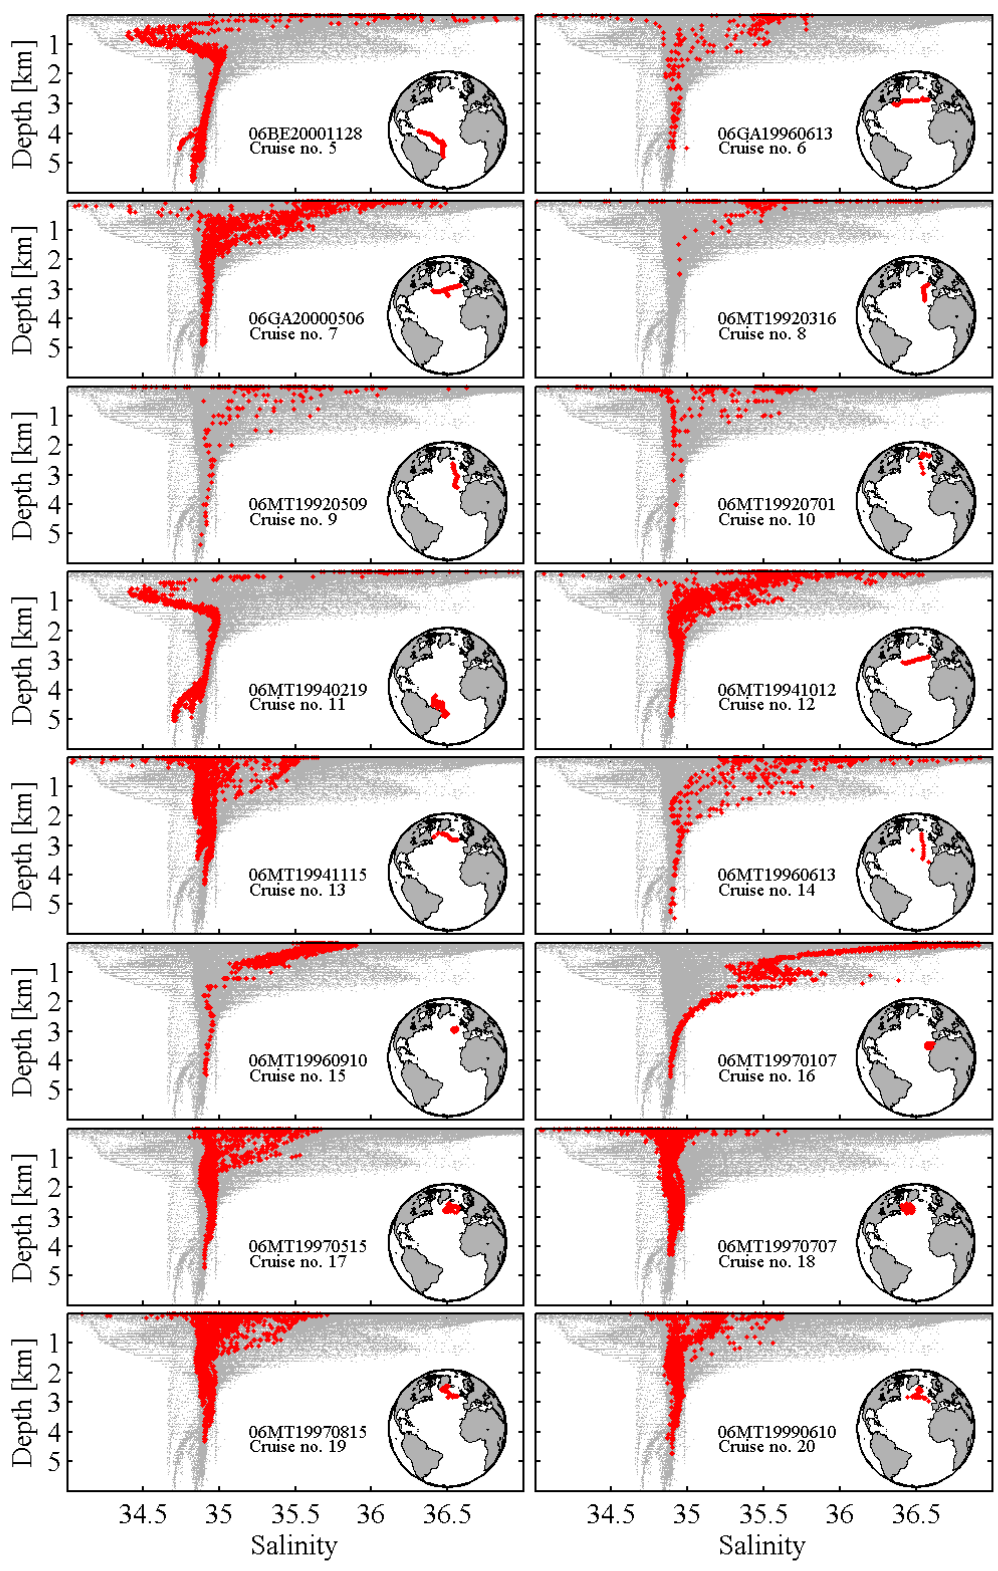
Figure 3. Salinity profiles and station locations of all the CARINA-ATL data; gray dots are all the salinity data; red dots the salinity belonging to that particular cruise. Note that these are the adjusted